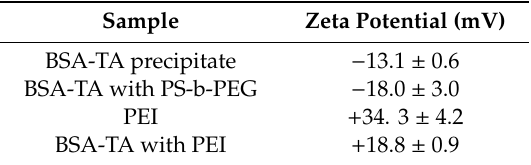
Table 1. Zeta potential of BSA-TA complex with polymer stabilizers.